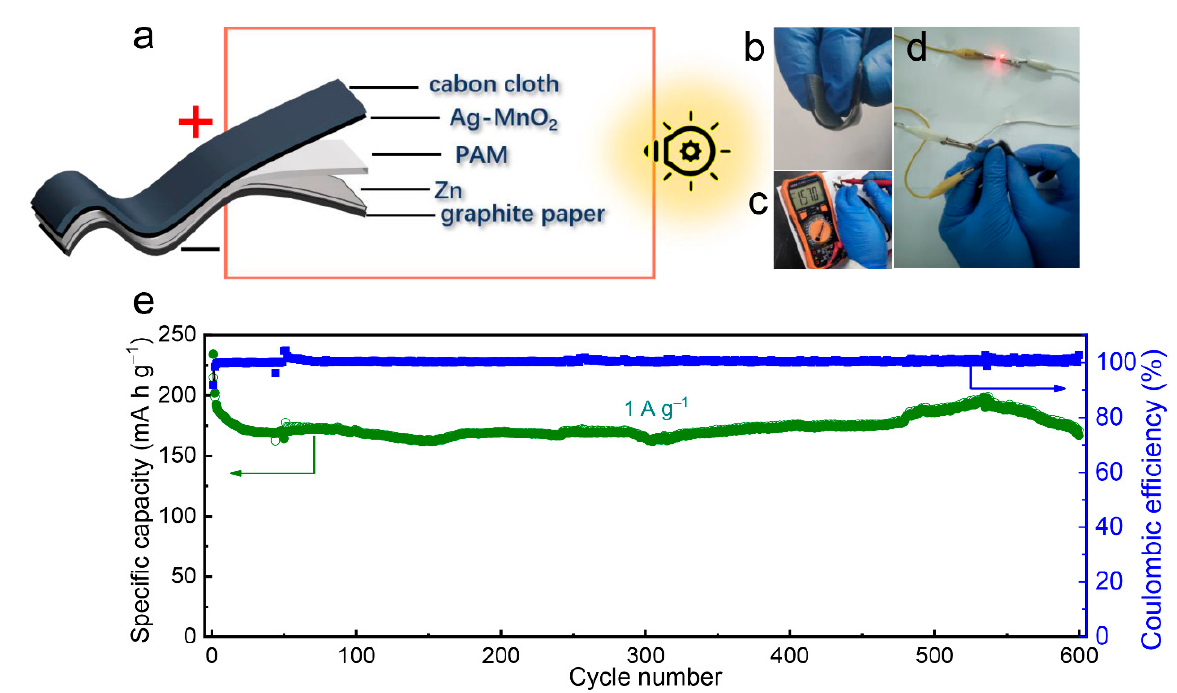
Figure 5. ( a ) Schematic diagram for the structure of our flexible quasi-solid-state ZIB. Photographs of the flexible quasi-solid-state ZIB ( b ) under bending condition, ( c ) showing the open circuit potential, and ( d ) used to drive a red LED under bending condition. ( e ) Long-term cycling performance and coulombic efficiency at 1 A g − 1 of the flexible quasi-solid-state ZIB.